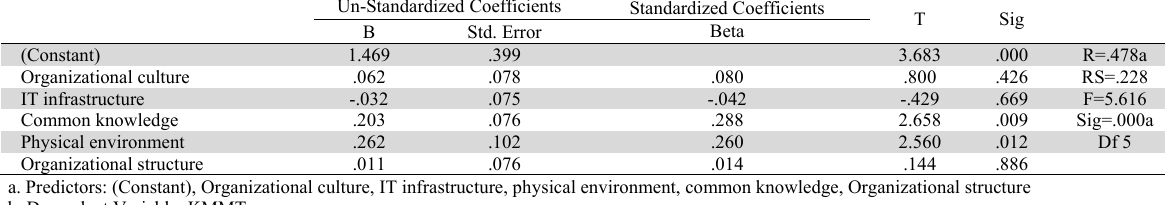
Results of the Multiple Regression Analysis of KM Infrastructure for KM Mechanisms and Technologies